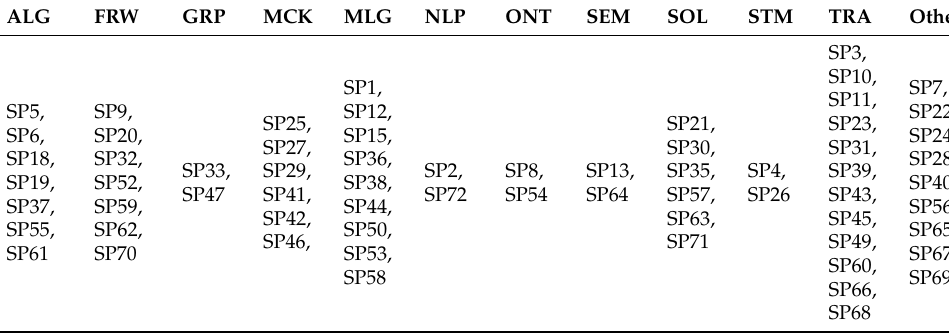
Figure 8. Technologies reported. Table 11. Selected papers and technologies reported.